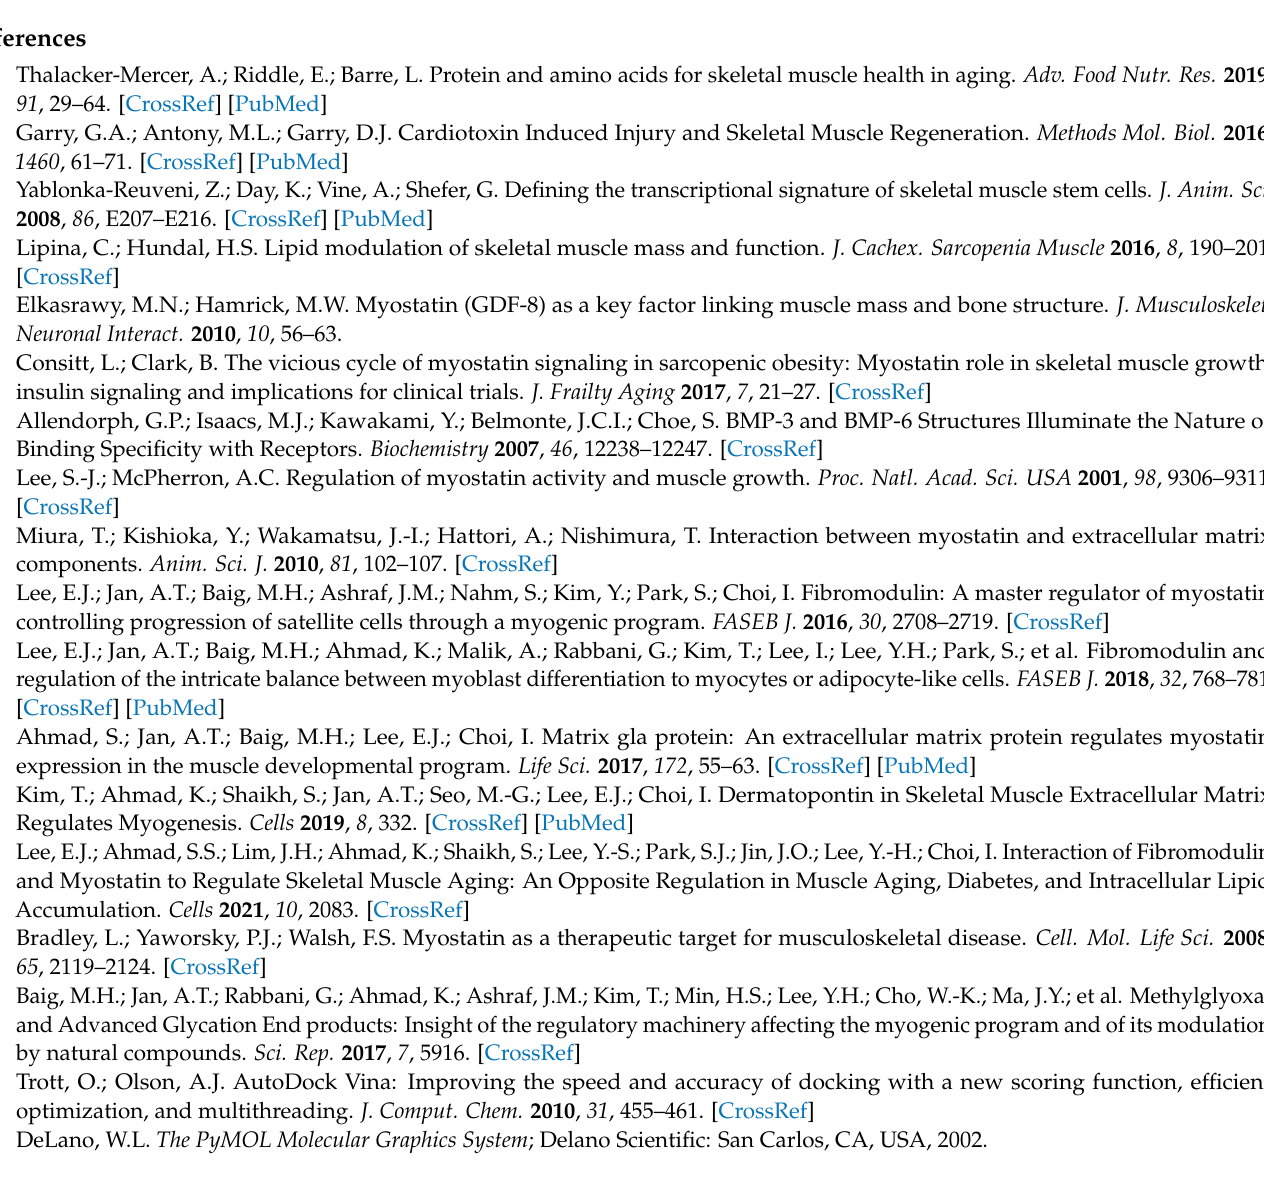
Table S2. Percentage of secondary structure element in MSTN